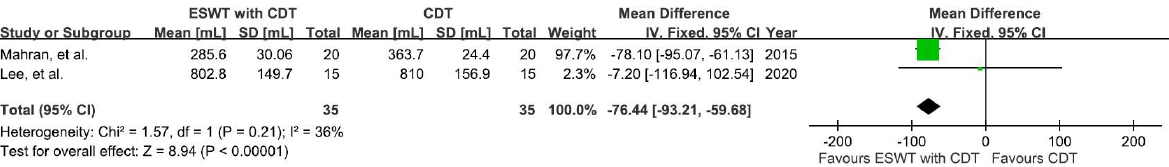
Figure 4. Mean difference (95%CI) in the effect of additional ESWT compared with CDT alone on the volume of BCRL.